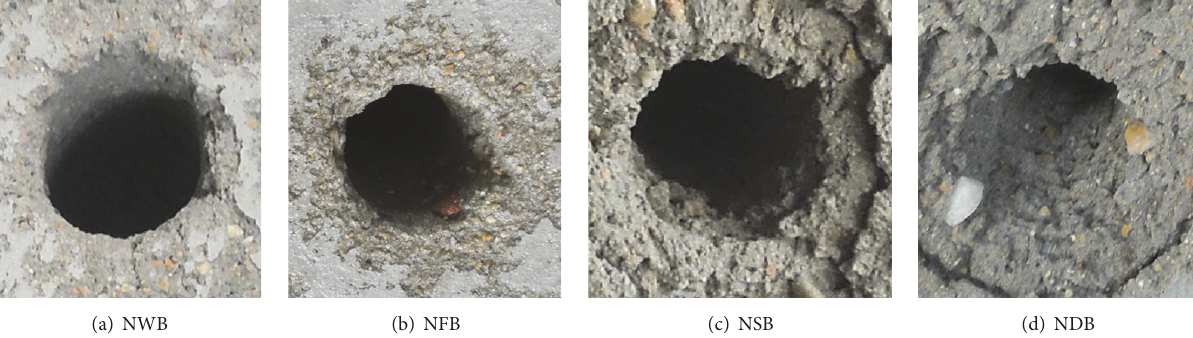
Figure 14: Orifice shape under different configuration modes.